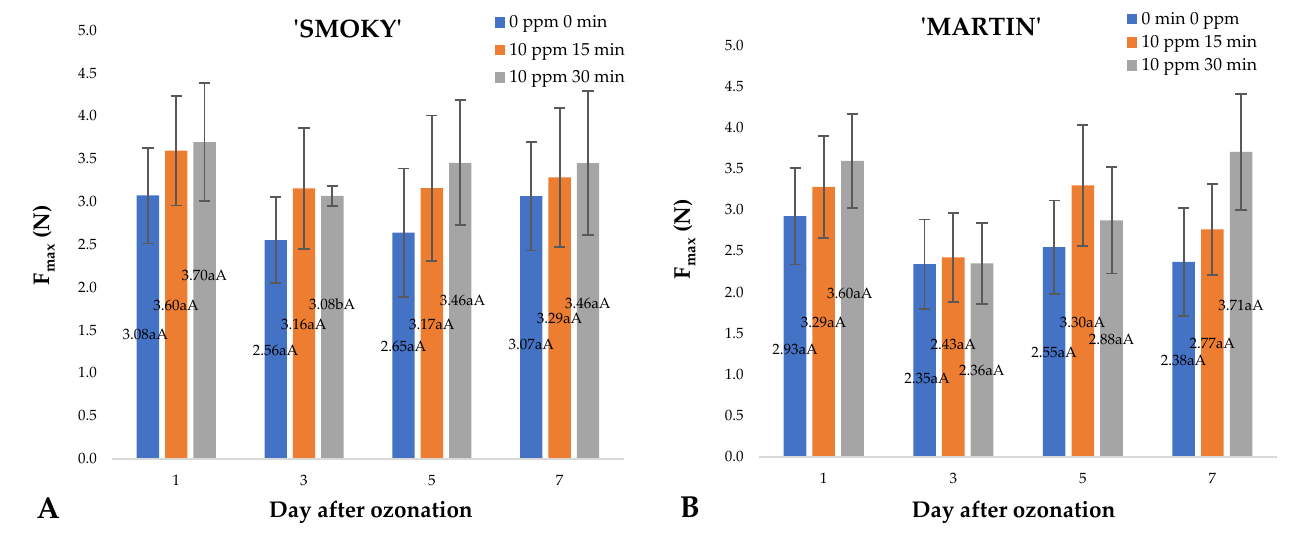
Figure 2. Mean values of maximum destructive force F max and standard error of the means for saskatoon berries of ‘Smoky’ ( A ) and ‘Martin’ ( B ) cultivars, relative to the dose of ozone ( n = 20). Note: Differences in results between the dose of ozone on the specific days are indicated by different small letters and difference between assessment days are indicated by different capital letters. Significance level p < 0.05.